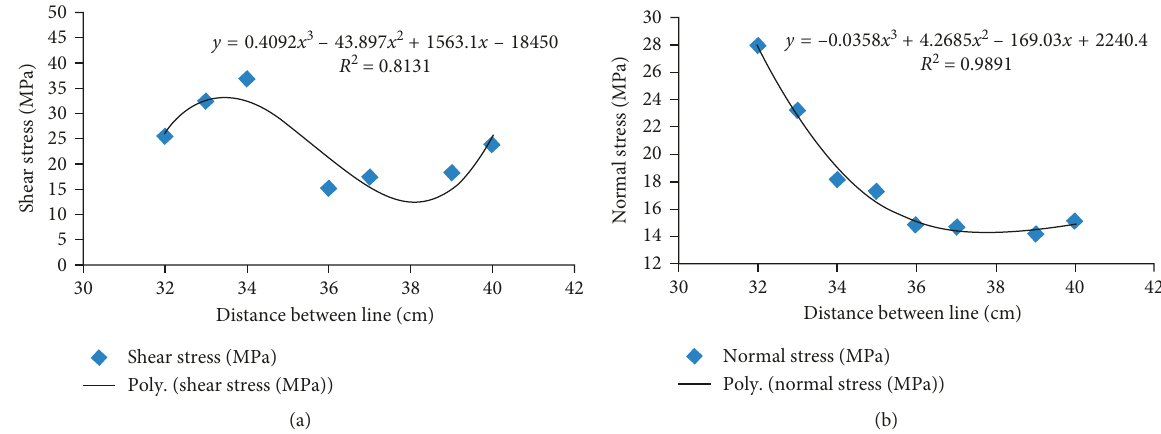
Figure 20: Maximum shear stress (a) and maximum normal stress (b) as a function of the distance between the rows of holes in the staggered mesh.